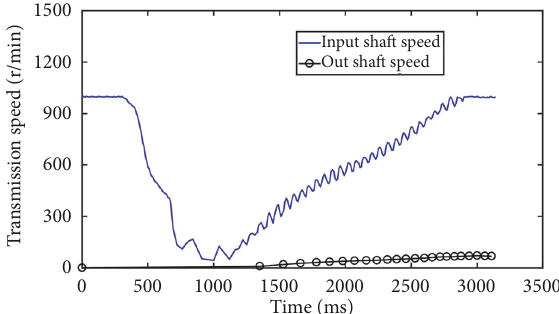
Figure 5: The transmission speeds during AMT startup under the first gear.